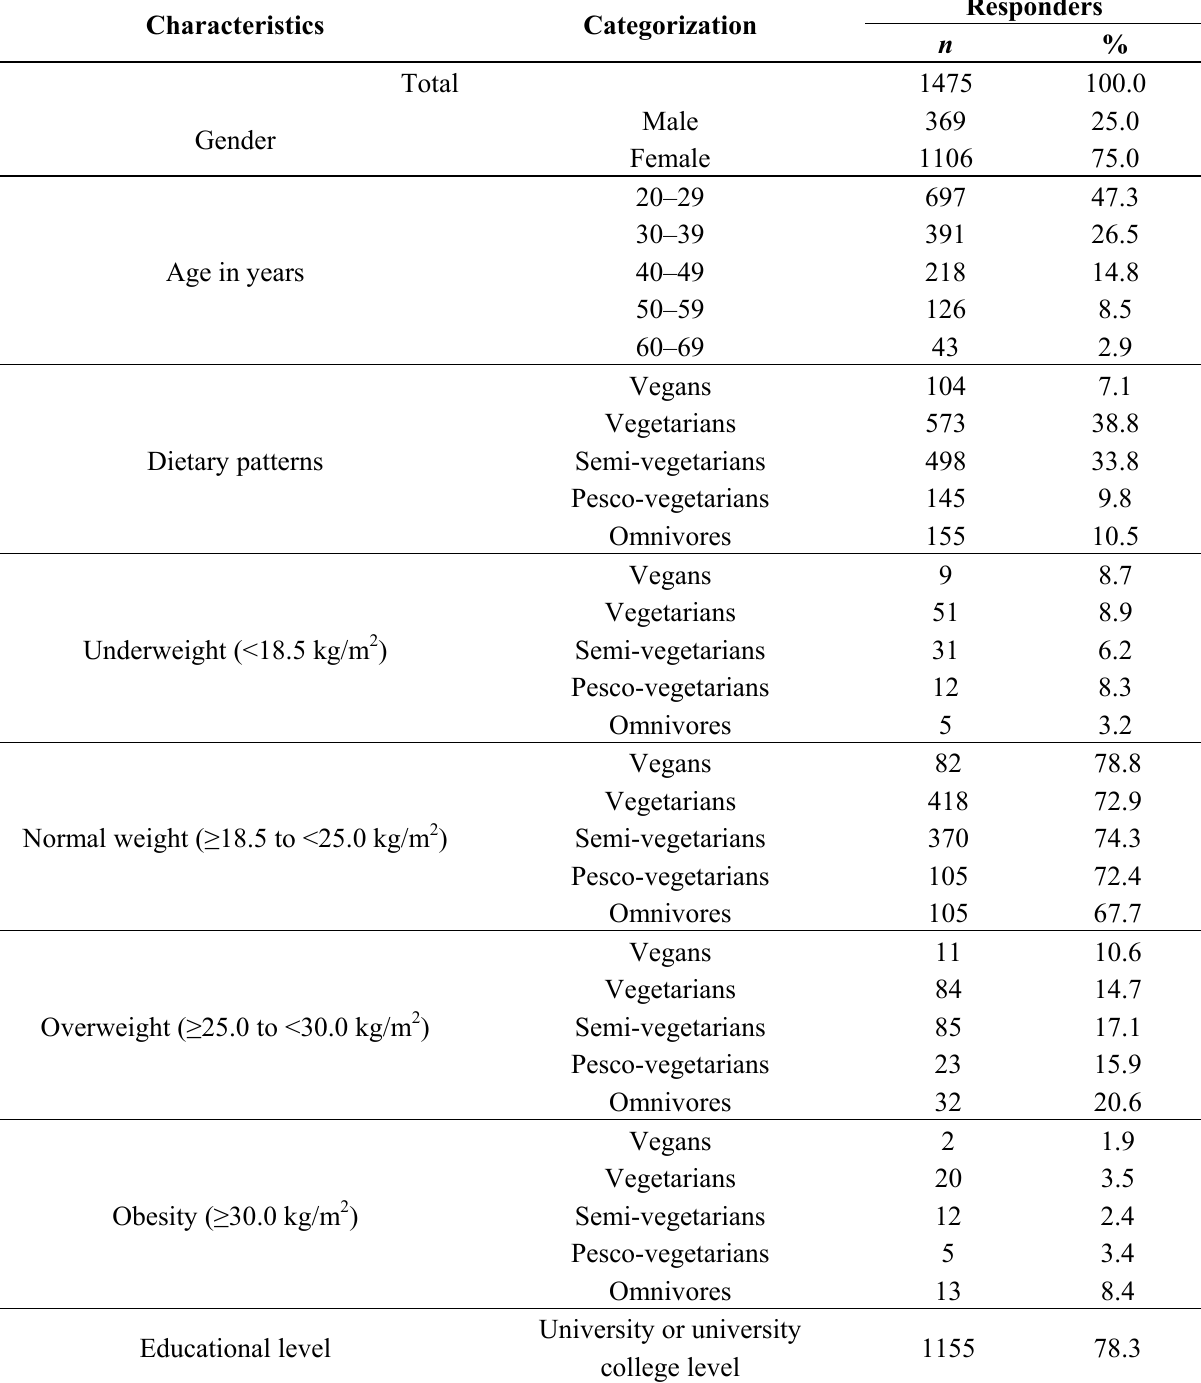
Table 1. Characteristics of the study